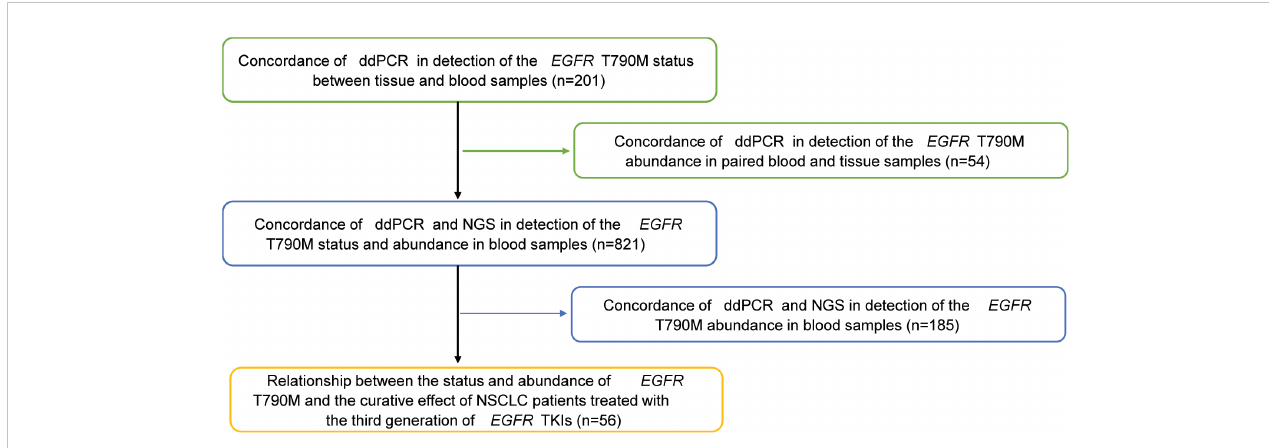
FIGURE 1 Flow chart of this